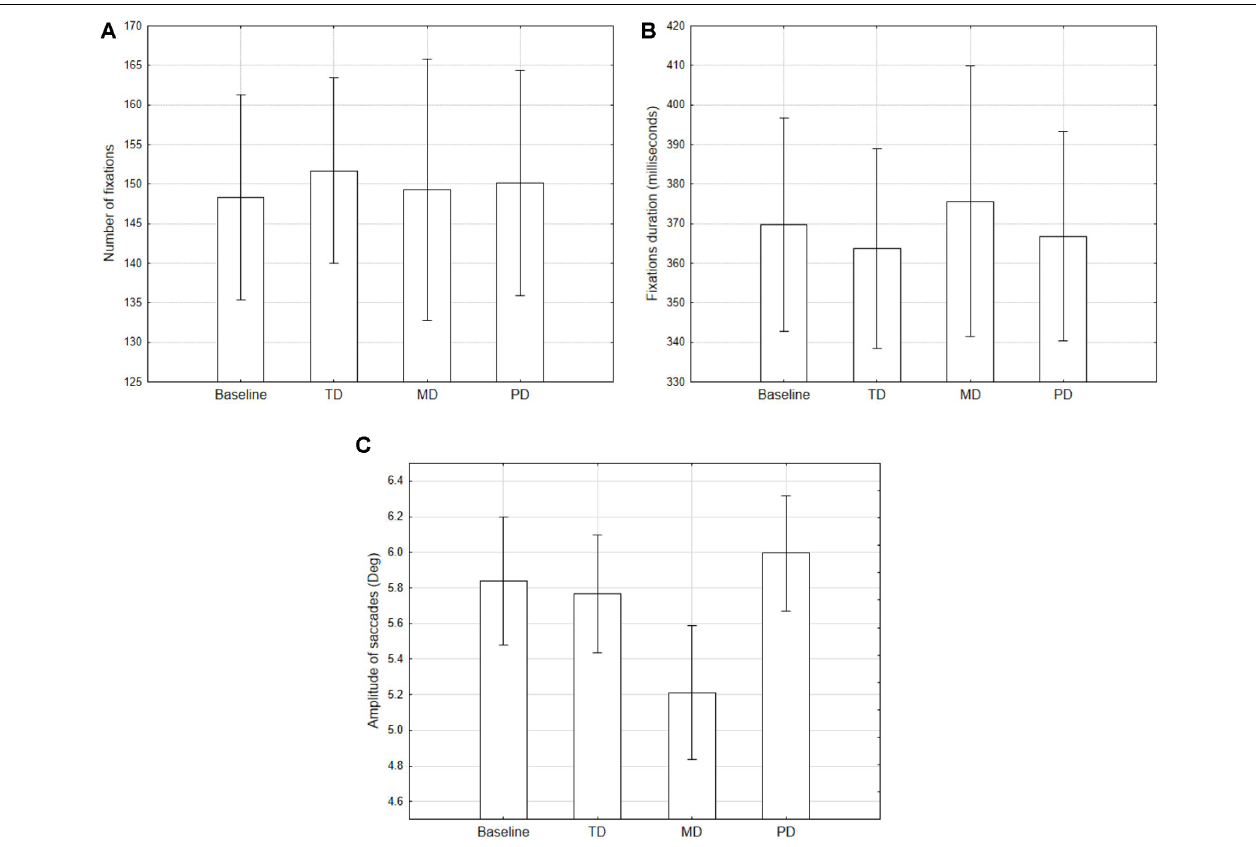
FIGURE 4 | Averaged number (A) and duration (B) of fixations, and amplitude of saccades (C) , for the conditions compared with the baseline. Error bars denote 0.95 confidence